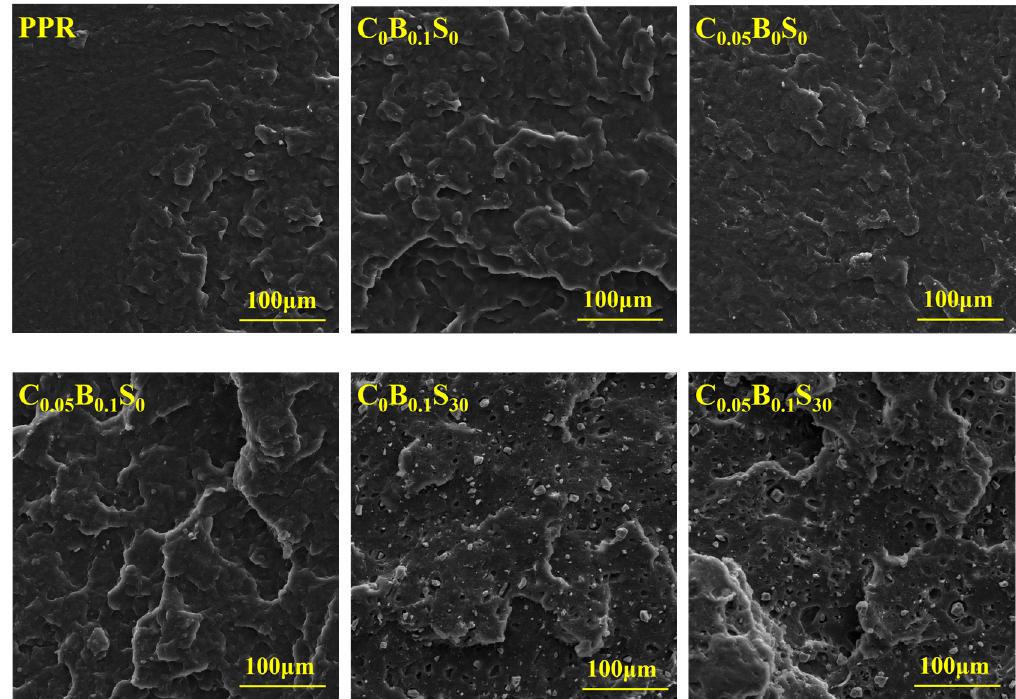
Figure 7. The impact fractured surface of the PPR and its blends (at 20 °C).